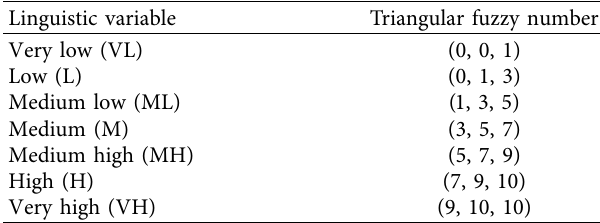
Table 2: Linguistic variables for rating failure